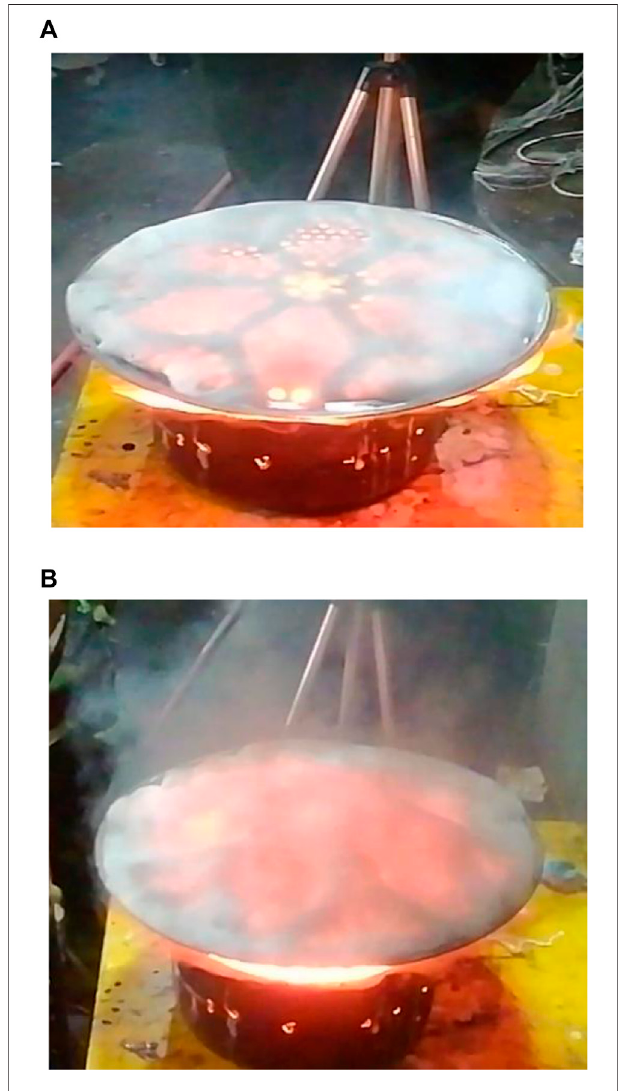
FIGURE 9 | Foam with 8124 (A) at 0 s; (B) at 24 s.